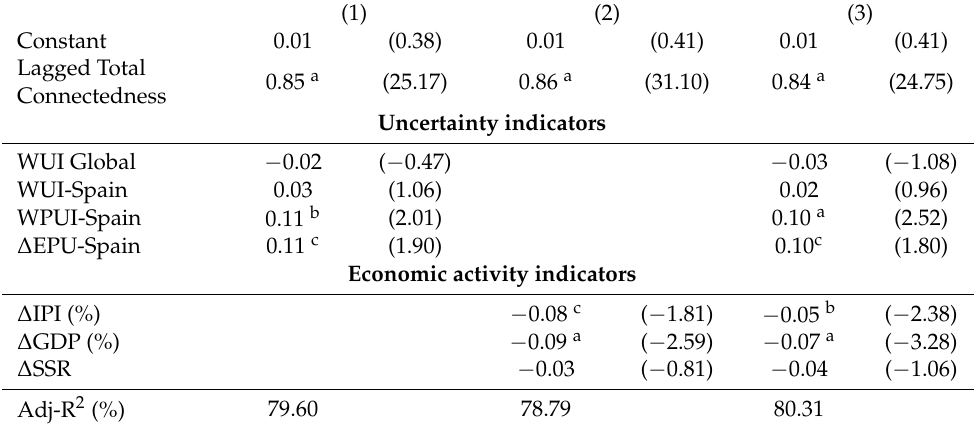
Table 4. Determinants of the dynamic total